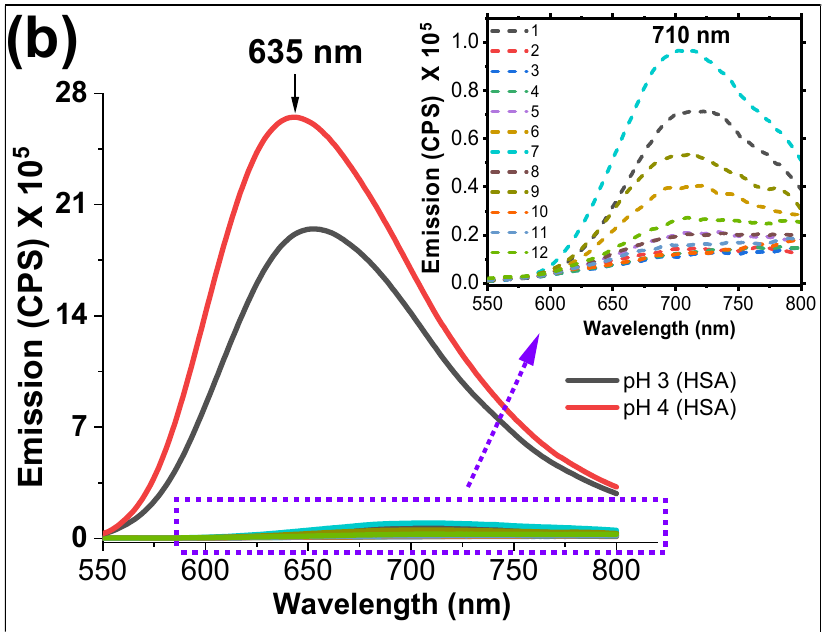
Figure 4. Absorption ( a ) and fluorescence ( b ) spectra were recorded for 3b (1 × 10 −5 M) in different aqueous acidic environments. At pH, 10 µL of 10% HSA solution was introduced into the acidic solutions of probe 3b . The probe was excited at 510 nm and the emission was recorded from 550 nm to 800 nm.